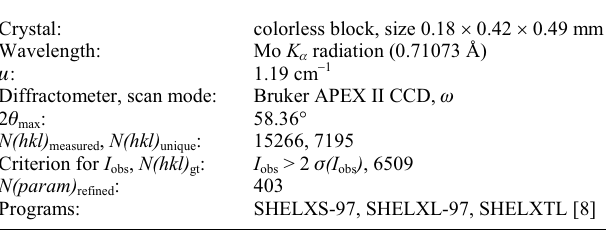
Table 1. Data collection and handling.